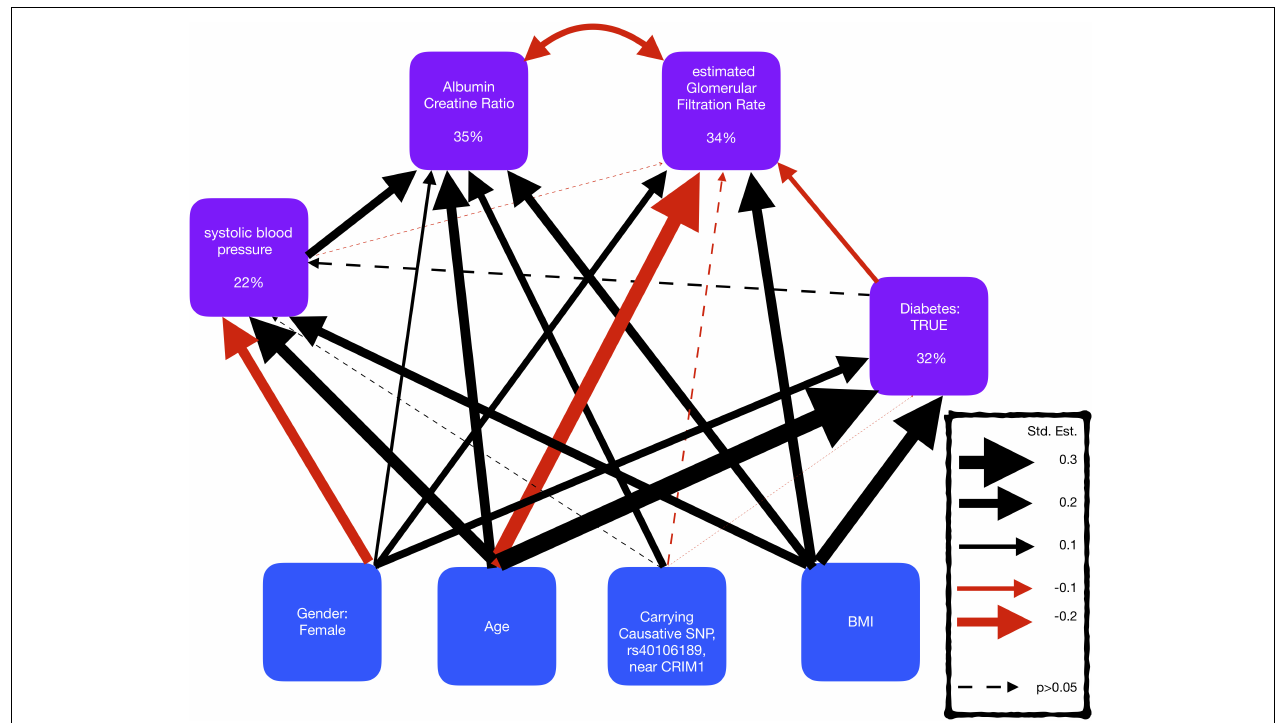
FIGURE 4 | Representation of a structural equation model, exploring the comorbidity of kidney disease, blood pressure, and diabetes. The boxes represent the measures and the arrows show the relationships between the variables (black/red arrows for positive/negative relationships, respectively). The thickness of the arrows has been scaled based on the magnitude of standardized regression coefficients for putative causative relationships (straight arrows) and correlation coefficients for correlated variables (curved arrows). The line type of the arrow denotes significance (solid = > p -value < 0.05; dotted = > p -value > 0.05). The percentage variance explained by the risk factors is also shown in the boxes. The models also adjusted for cohort, but coefficients are not shown here to make the graphs